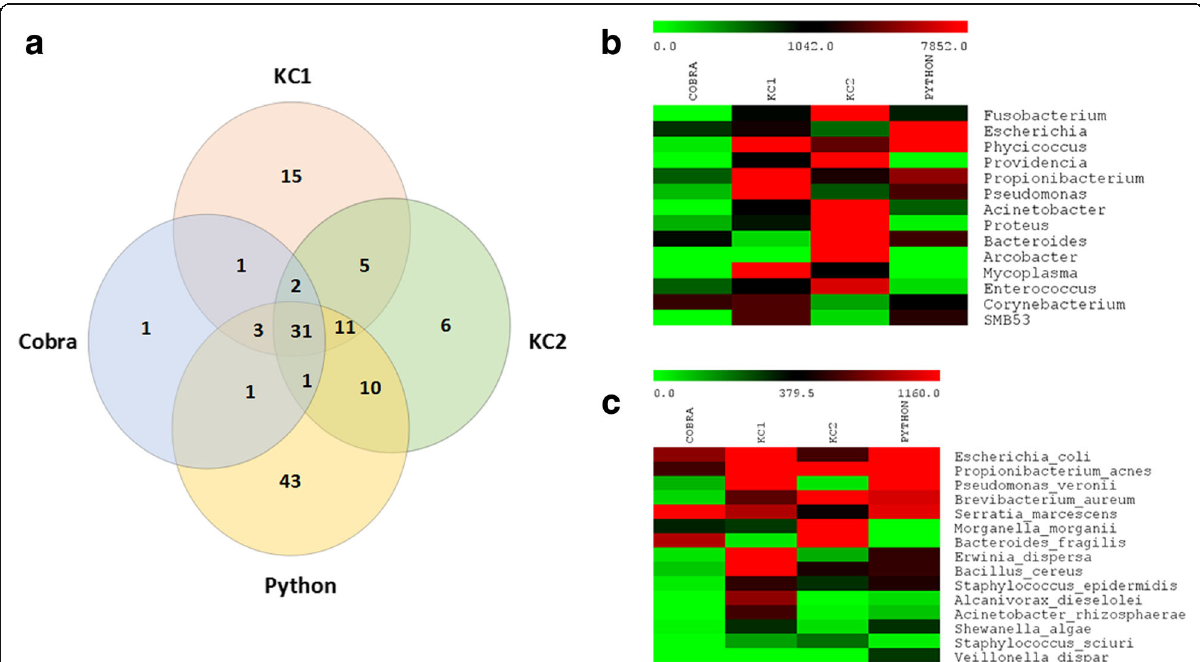
Fig. 3 Venn diagram and heat-map representation of bacterial species identified among snake oral samples. a Venn diagram shows the number of common and uniquely identified species. There are 31 bacterial species commonly present (out of total 147 bacterial species) among Python, Cobra, King Cobra 1 and King Cobra 2; b Heat map indicates the most abundant bacterial genera among these snakes; c Heat map shows top 15 commonly abundant bacterial species in descending order